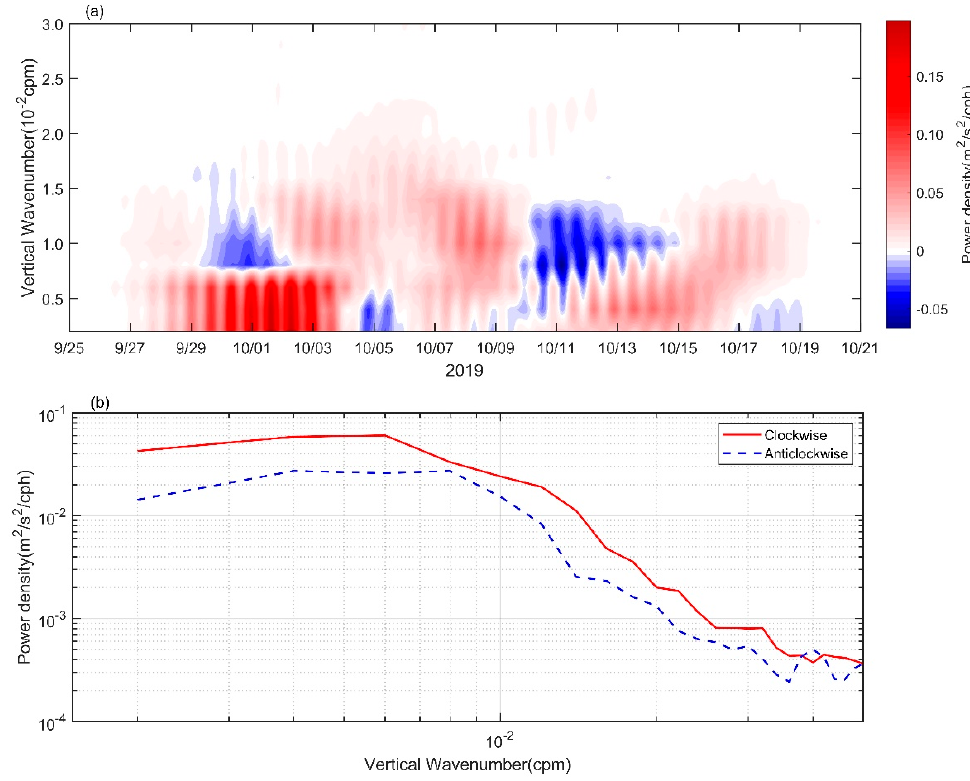
Figure 7. ( a ) Wavenumber − time map of S − − S + . ( b ) Plot of rotary vertical wavenumber spectra averaged from 25 September to 20 October 2019. The blue dashed line and red line represent anticlockwise and clockwise rotations with a depth component. cpm stands for “cycles per meter”.